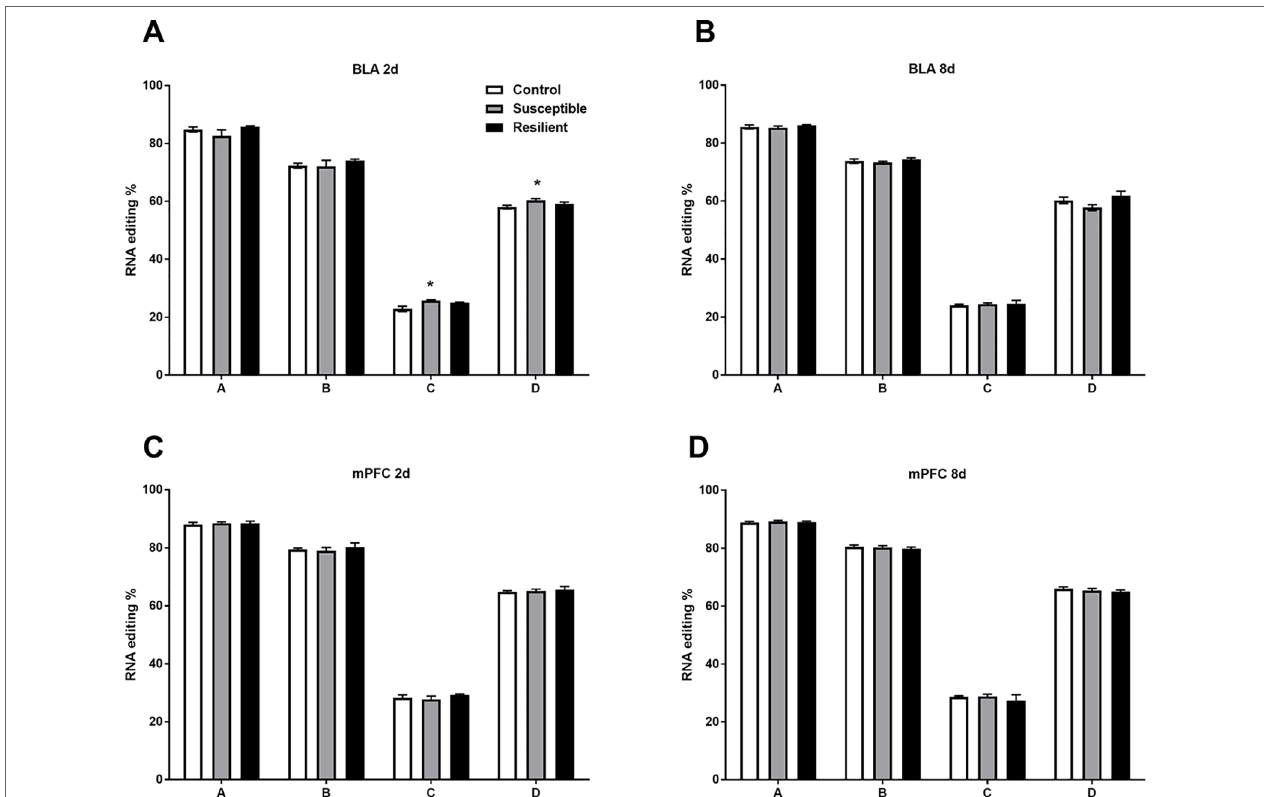
FIGURE 4 | RNA editing of the Htr2c transcript is altered within the BLA of susceptible mice 2 days following CSDS. Sequencing analysis revealed modest increases of RNA editing at Htr2c sites C and D within the BLA of susceptible but not resilient mice 2 days following CSDS (A) with no other changes observed at 8 days (B) or at 2 days (C) or 8 days within the mPFC (D) . Control 2 days, n = 6–8; susceptible 2 days, n = 10; resilient 2 days, n = 4; control 8 days, n = 7–8; susceptible 8 days, n = 7; resilient 8 days, n = 3. * p < 0.05, one-way ANOVA with Sidak post hoc